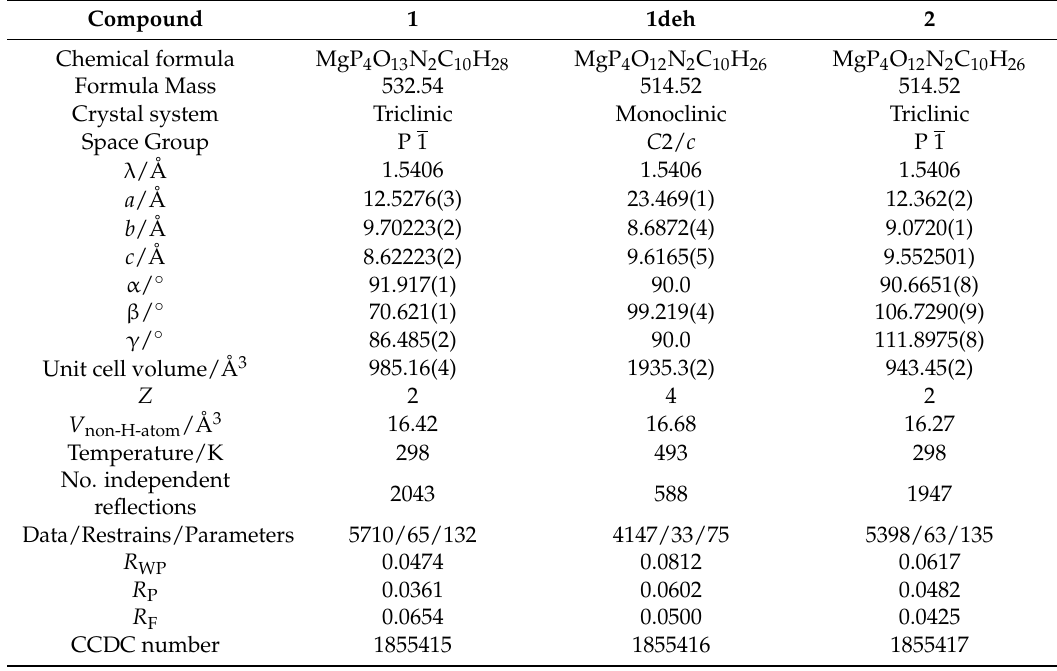
Table 1. Selected crystallographic data for magnesium tetraphosphonate materials from laboratory powder X ‐ ray diffraction.